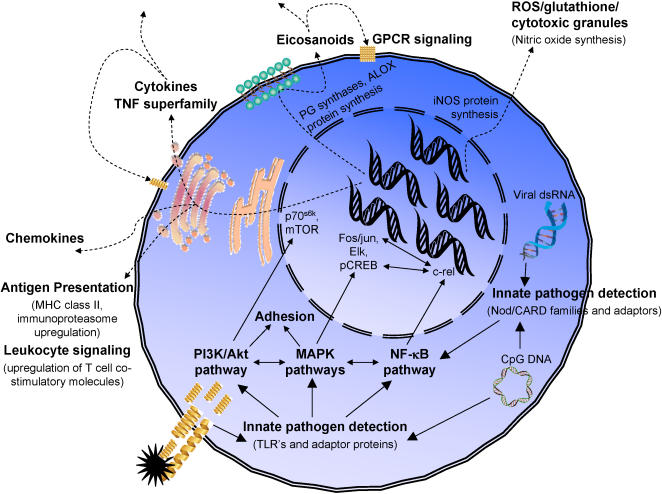
Inflammation subpathways involved in the response to danger signal.The concerted action of multiple functional subpathways in the initial response of a macrophage to bacteria or virus is depicted. Solid arrows indicate signaling events and dashed arrows stimulated production of proteins and other inflammatory mediators (including autocrine/paracrine responses of the macrophage to the released molecules).